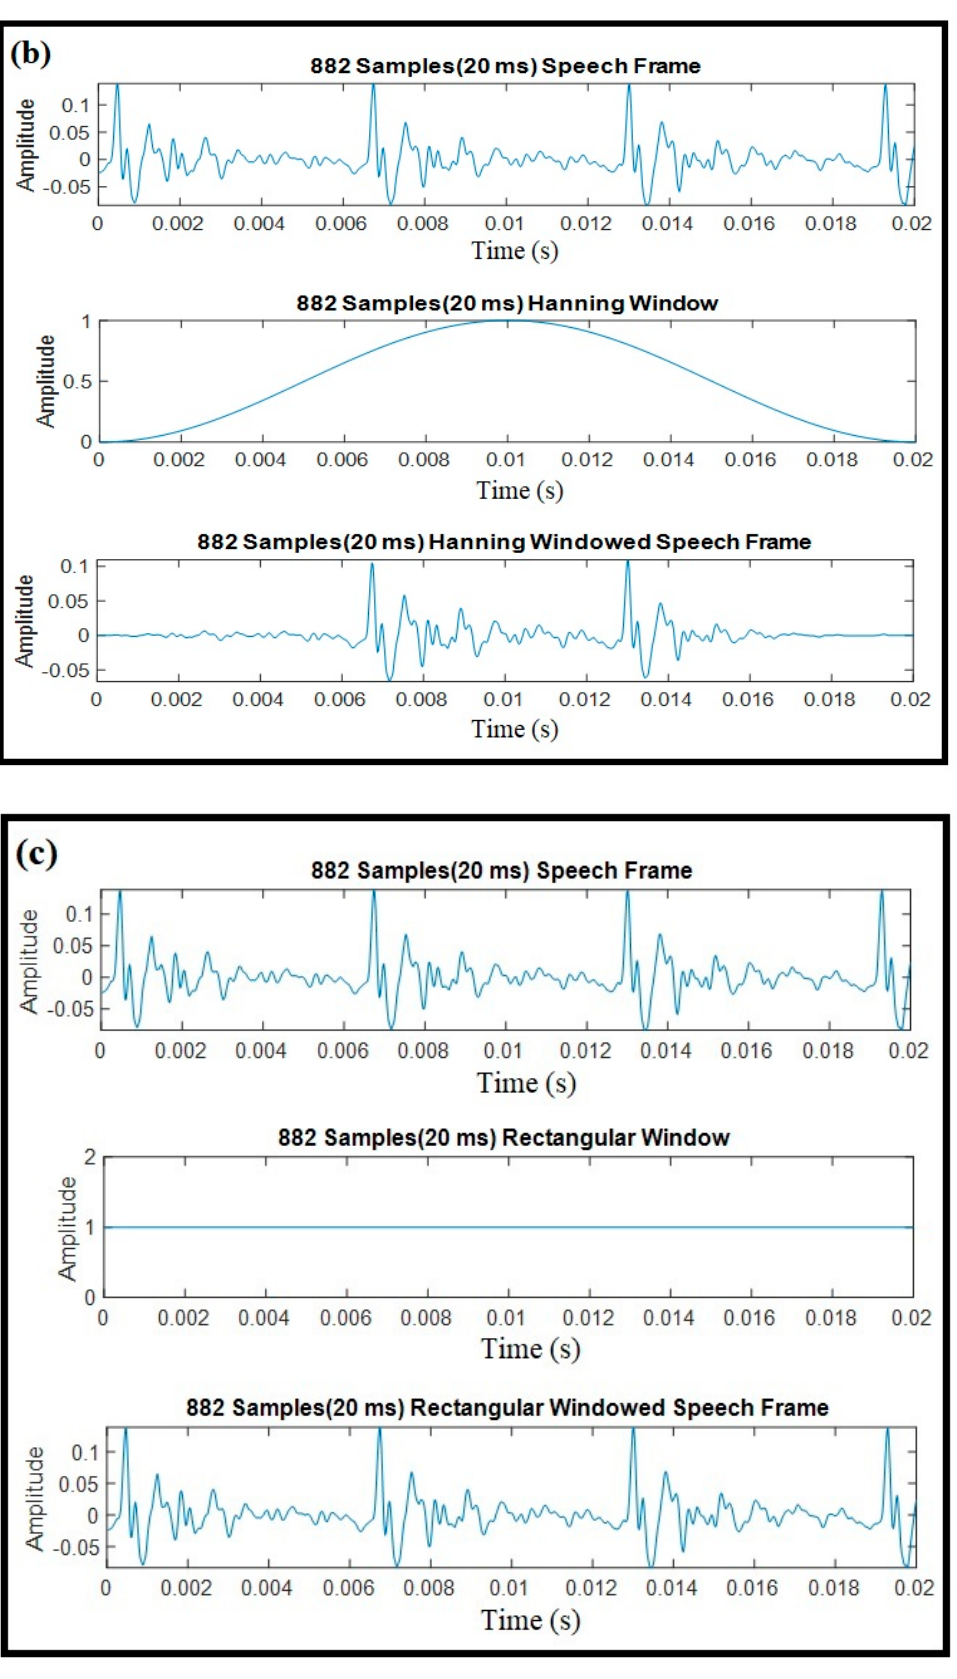
Figure 4. Examples of ( a ) Hamming, ( b ) Hanning, and ( c ) rectangular windows.